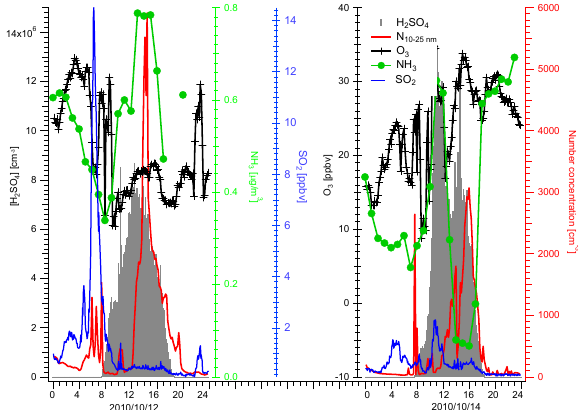
October 12 and 14, 2010. 704